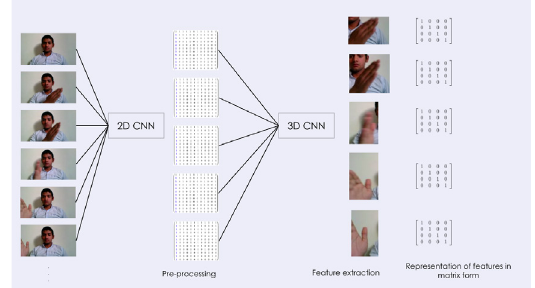
Fig 1. Work flow in